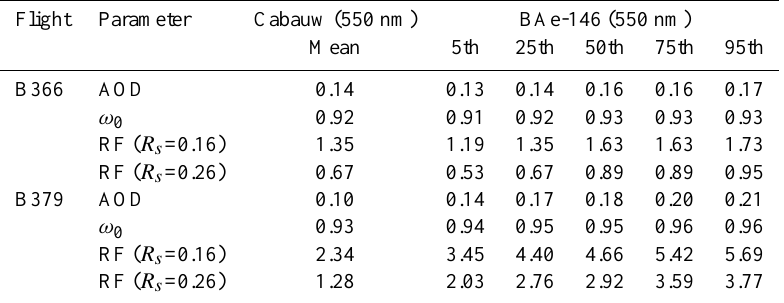
Table 4. Summary of optical properties for flight B366 and B379 when comparing between the measurements from the BAe-146 and estimated values based upon the ground-based measurements from Cabauw. The Aerosol Optical Depth (AOD) is calculated using the ambient scattering coefficient and the corresponding absorption value from 0–2km. ω 0 refers to the average single scattering albedo for the vertical column from 0–2km. RF refers to the calculated negative radiative forcing based upon the AOD, ω 0 and the surface albedo ( R s ) values used. The solar constant is normalised by the cosine of the solar zenith angle (56 ◦ during this period for B366 and 32 ◦ for B379) in order to account for the sun’s location not being directly overhead. Flight Parameter Cabauw (550 nm) Mean